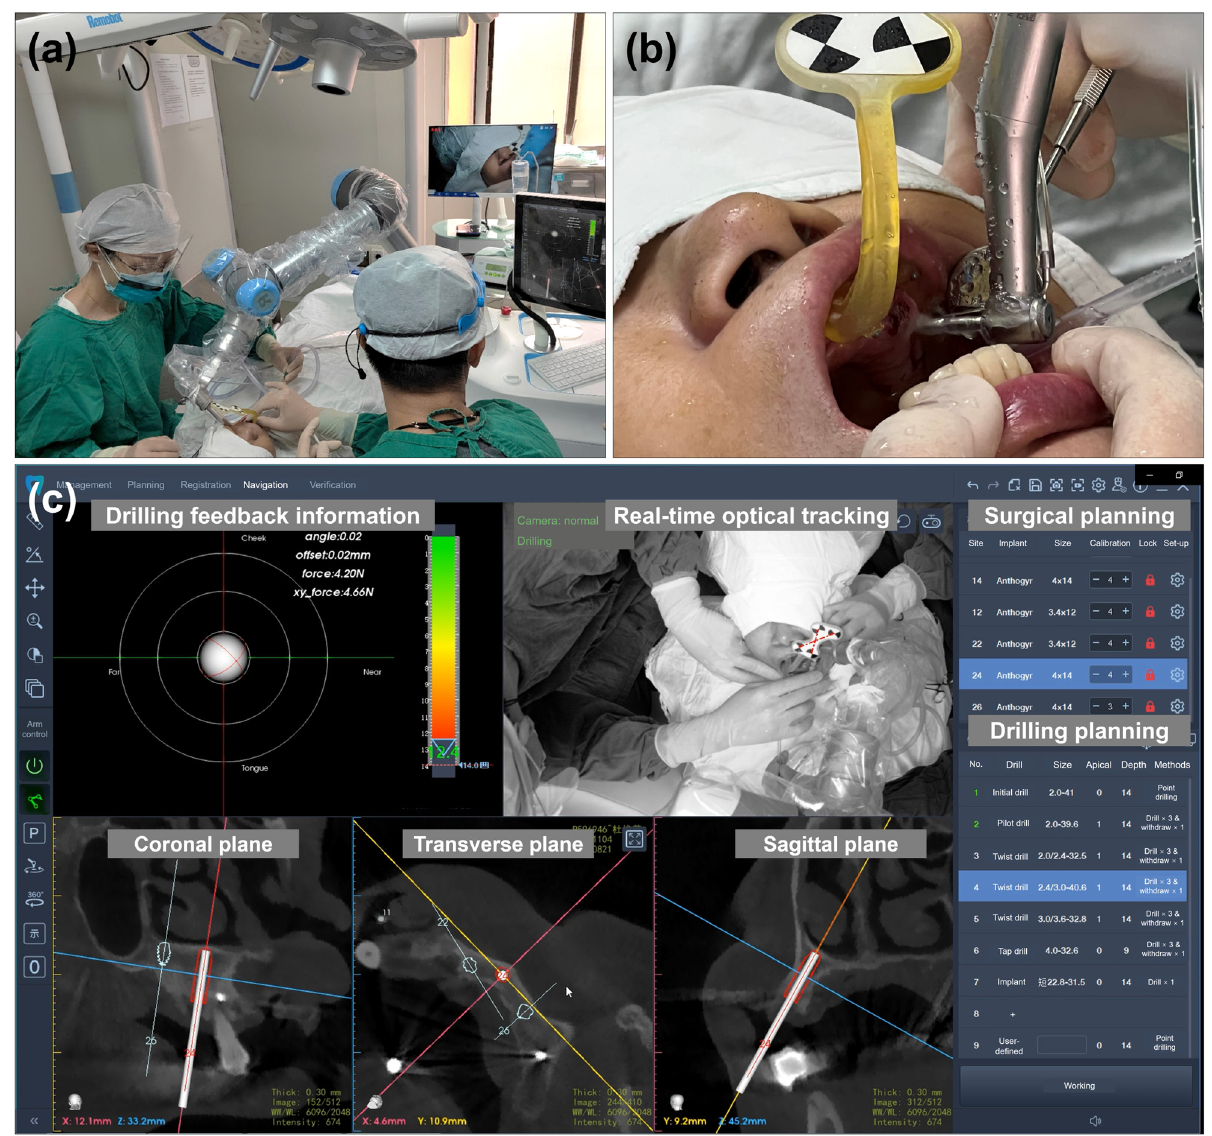
Figure 6. Intraoperative image and autonomous osteotomy procedure. ( a ) The autonomous implant osteotomy was performed by the image-guided robotic surgery system; ( b ) autonomous implant osteotomy at site #24; and ( c ) robot-assisted surgical software system.